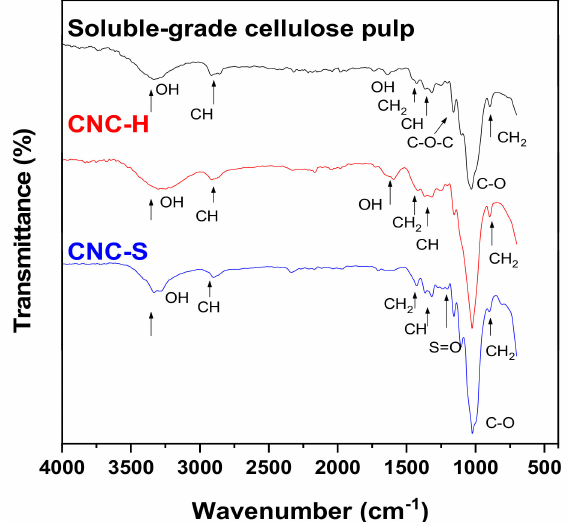
Figure 4. FTIR spectra comparison for soluble-grade cellulose pulp, CNC-H (E10H), and CNC-S